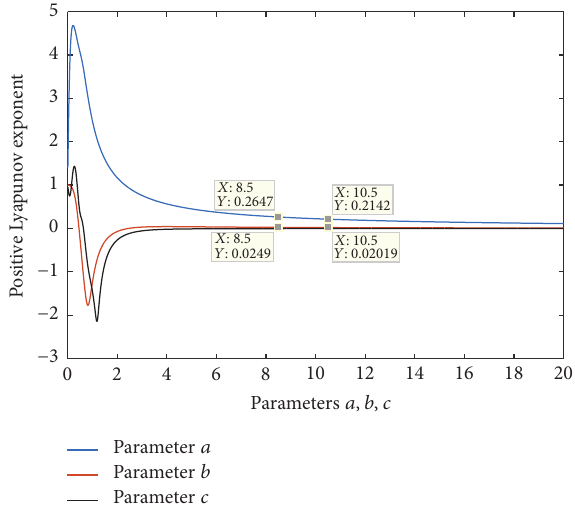
Figure 3: Positive Lyapunov exponent for variation in parameters ( 𝑎,𝑏, 𝑐 ).